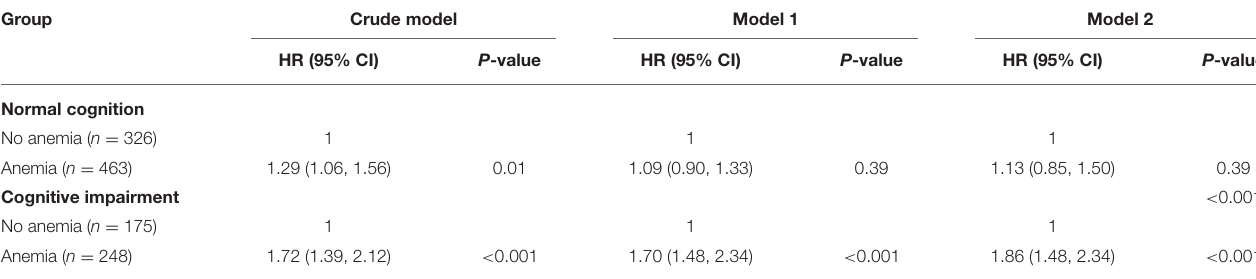
TABLE 4 | Hazard ratios for the association between anemia and all-cause mortality by cognition impairment or not. Group